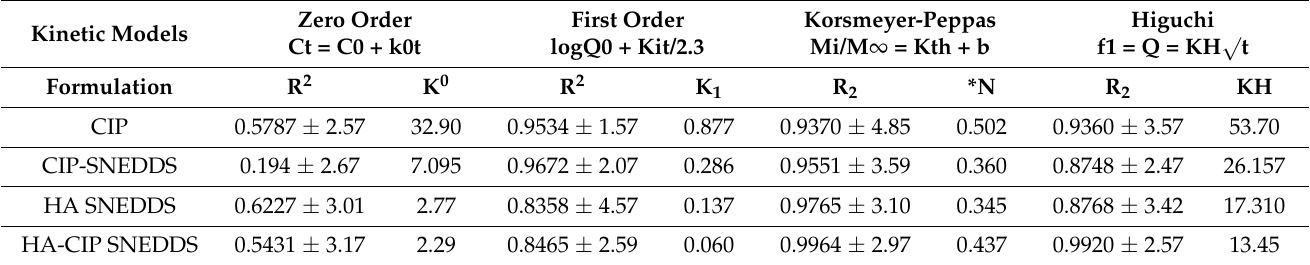
Figure 4. XRD spectra of HA ( a ), CIP ( b ), and HA-CIP ( c ), respectively. Table 4. Kinetic models to evaluate the mechanism of CIP drug release from polymeric SNEDDS.